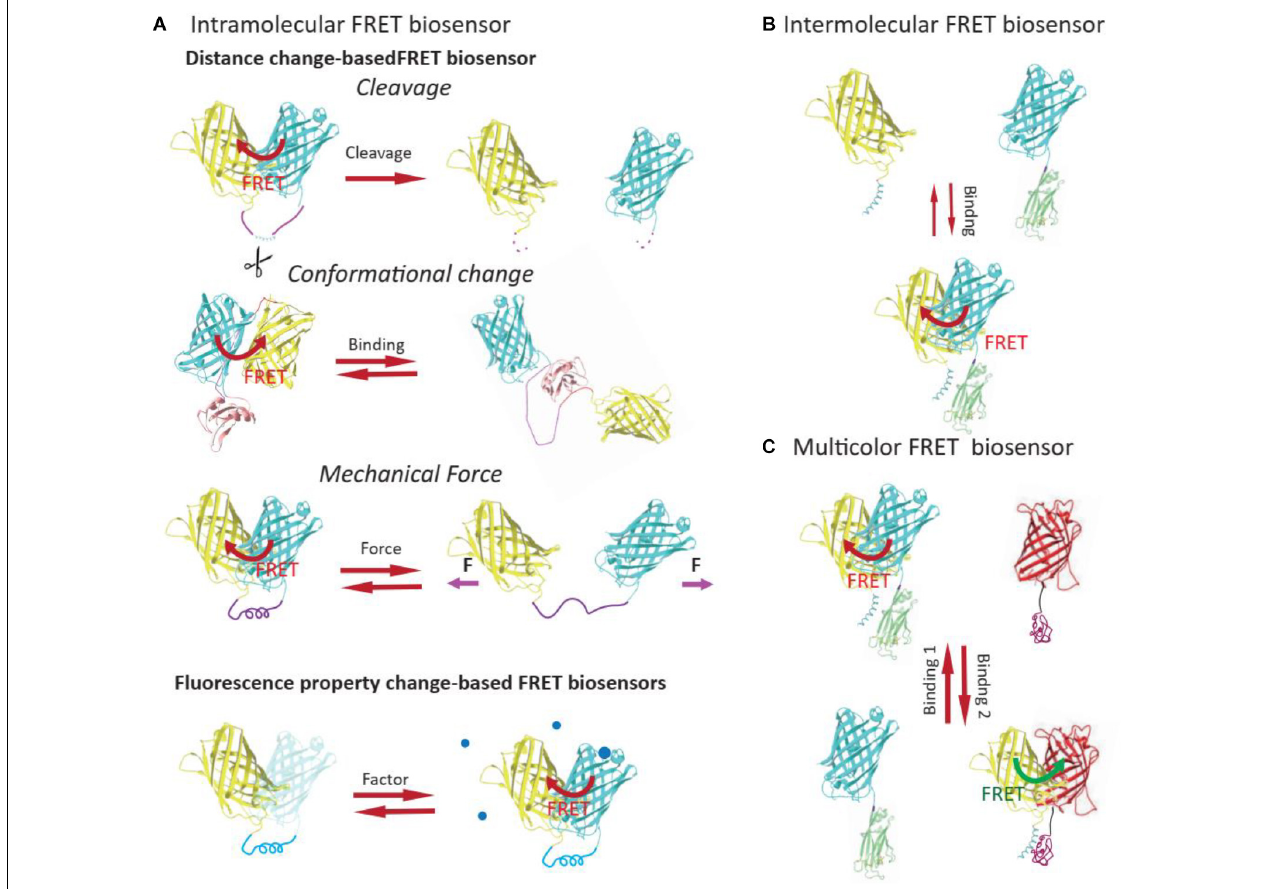
FIGURE 2 | Classification of FRET biosensors. Based on whether the donor and the acceptor are on the same molecule, FRET biosensors can be classified into intramolecular (A) or intermolecular FRET biosensors (B) . The intramolecular FRET biosensor could be further classified into distance change-based FRET biosensor or FP property change-based FRET biosensors, based on the mechanism of FRET ratio change. (C) Multicolor FRET biosensors usually contain more than two FPs and could be used for imaging of different cellular events in the same live